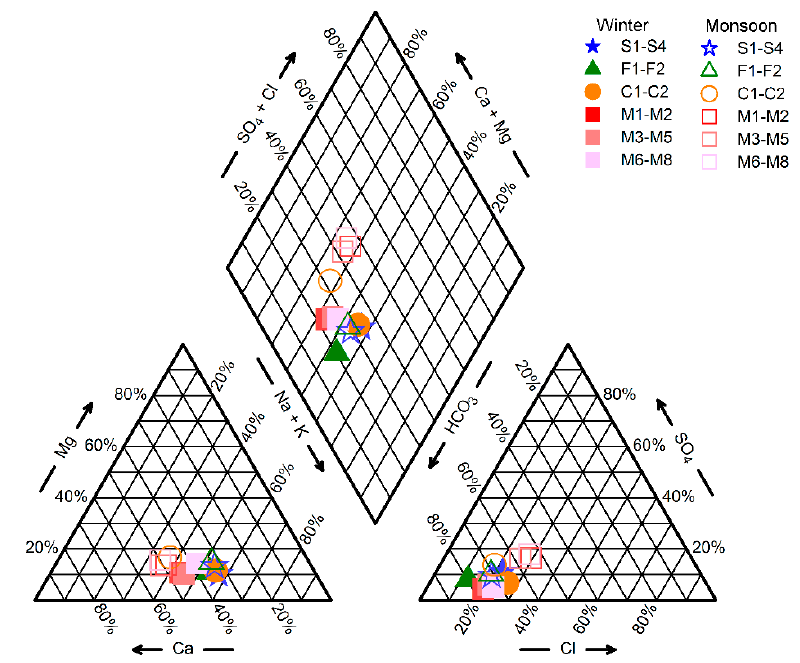
Figure 6. Piper diagram with the water facies for the Nongkrem and Umiew nested catchments system during winter and monsoon seasons.